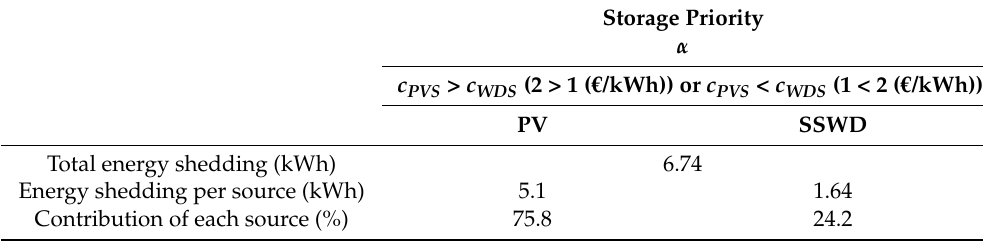
Figure 7. PV and SSWD shedding curves by applying the α coefficient in the case of priority storage. Table 3. Energy shedding calculation for the α coefficient in the case of storage priority.